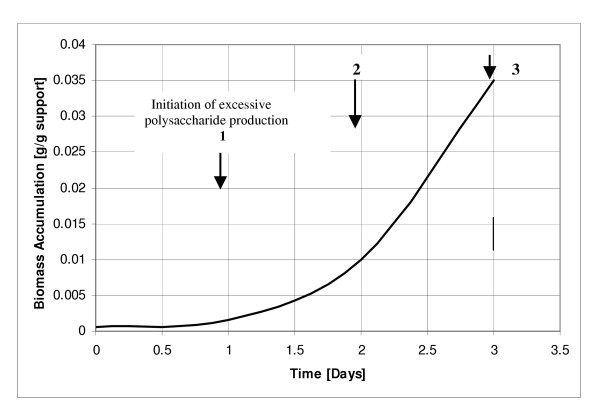
Production of polysaccharide and accumulation of cell mass during the initial 3 days of adsorption of cells of C. acetobutylicum onto bonechar for the production of butanol from whey permeate in a packed bed reactor. 1. Initiation of excessive production of polysaccharide; 2. Maximum growth and attachment starts; 3. Biofilms become visible and polysaccharide production continues.